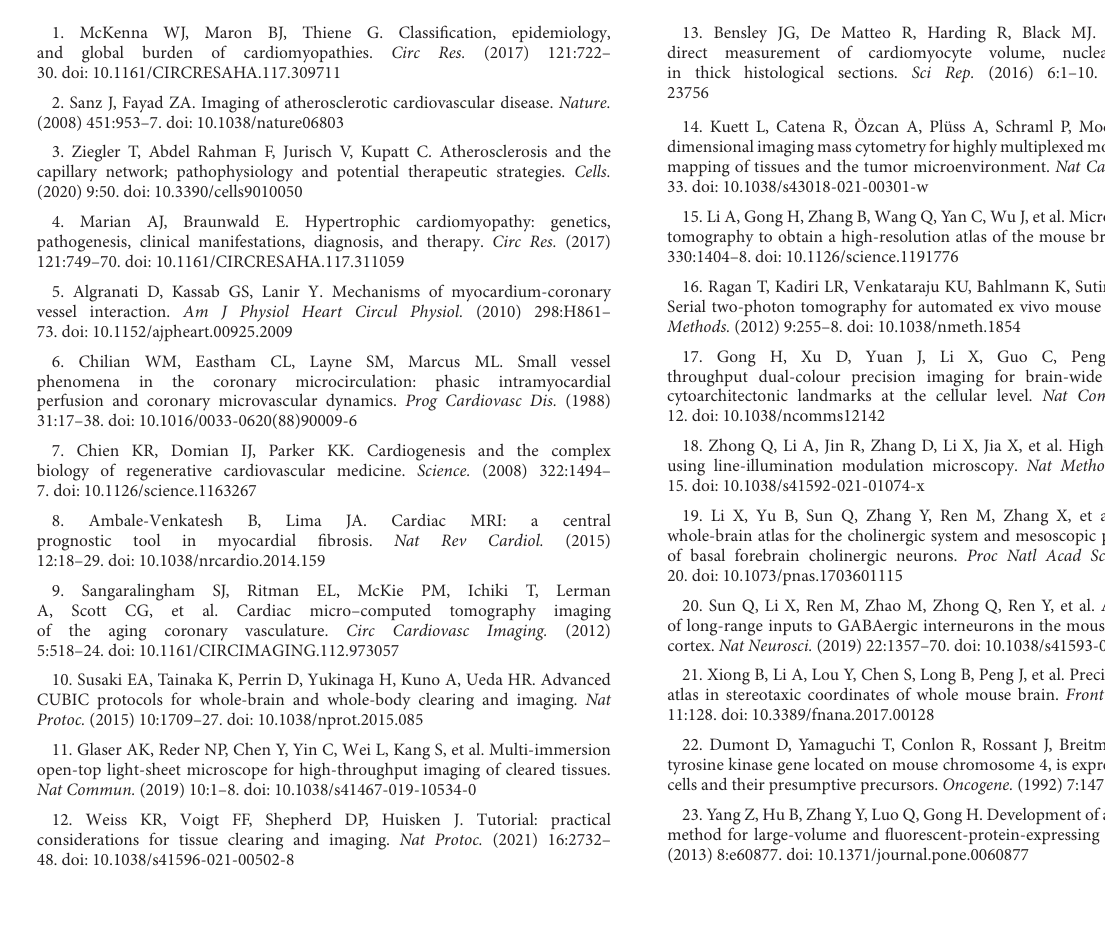
SUPPLEMENTARYVIDEO2 Rendered cardiovascular data shows the complex three-dimensional spatial winding of